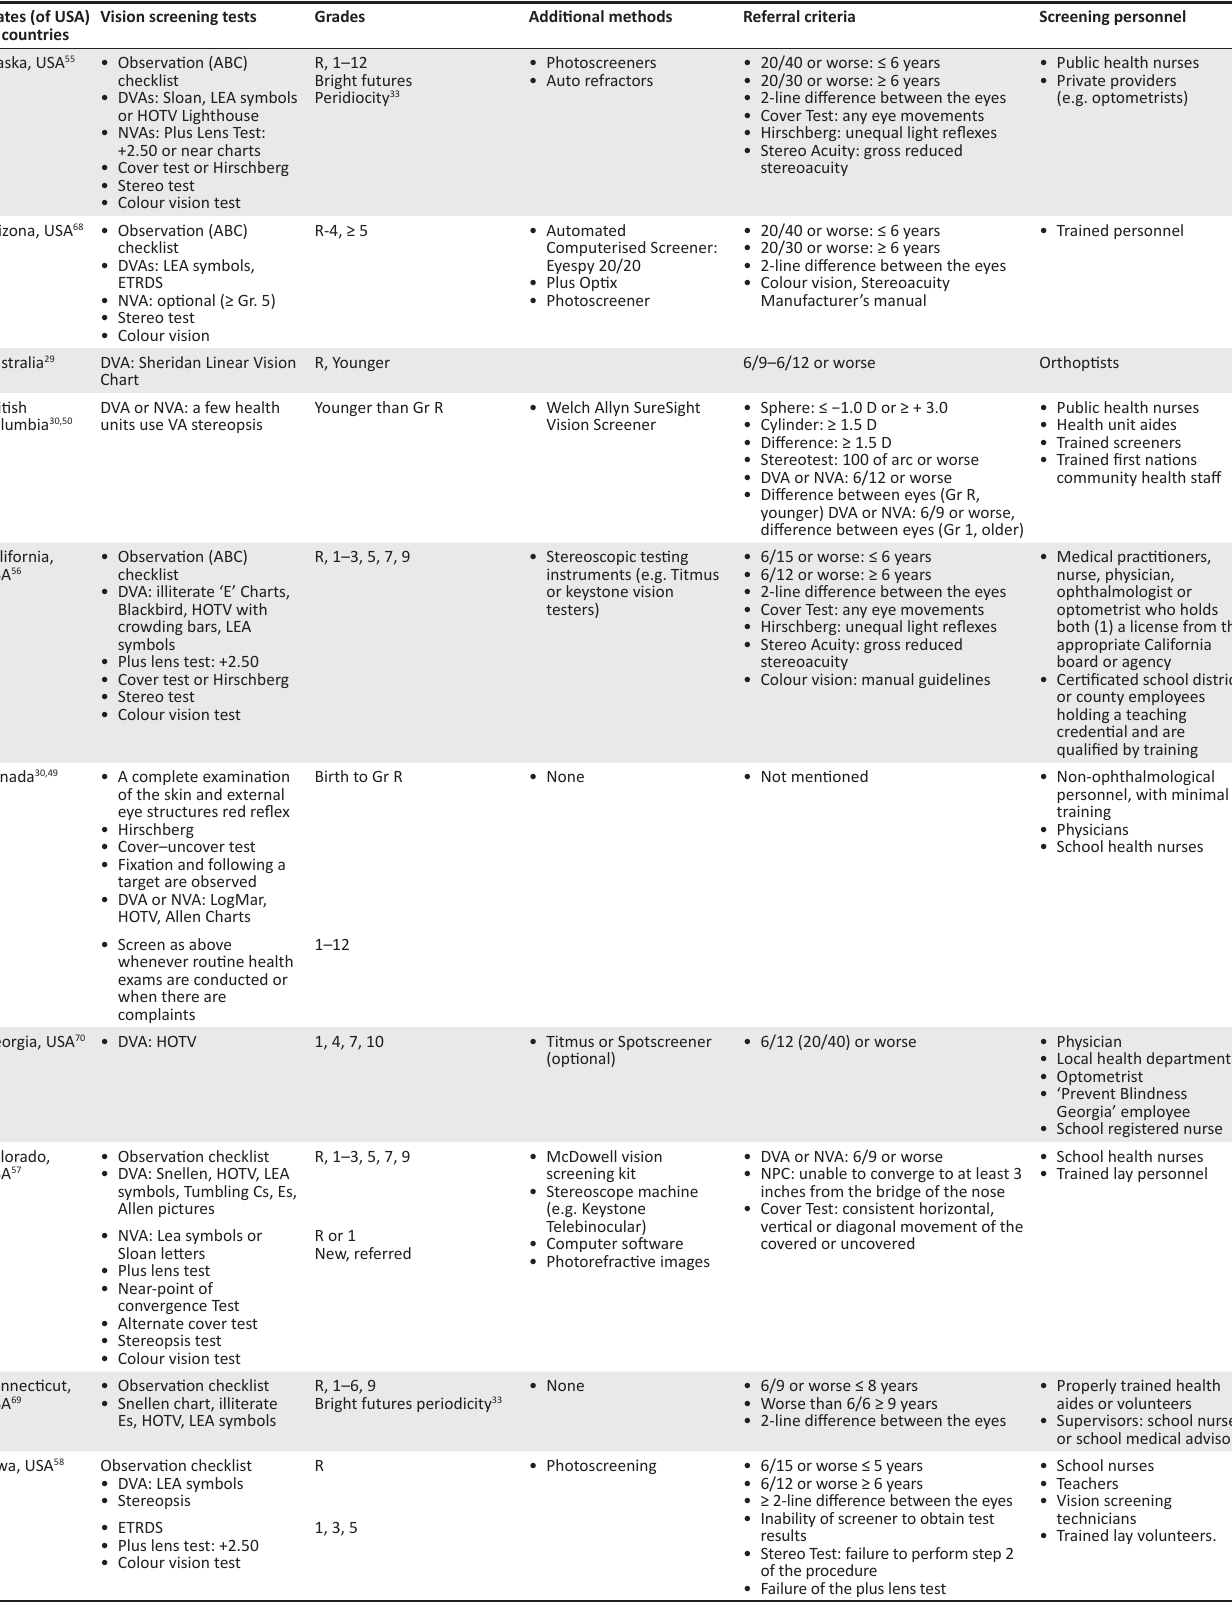
TABLE 1: International and national guidelines on children’s vision